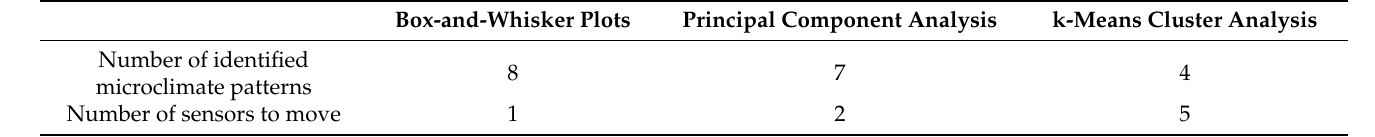
Table 6. Comparison among the results obtained by the three statistical methods. The number of sensors to move in the a posteriori deployment includes the identified redundant sensors and TRH28 placed in the first-guess configuration in the attic, where no artworks are exhibited or preserved. Box-and-Whisker Plots Principal Component Analysis k-Means Cluster